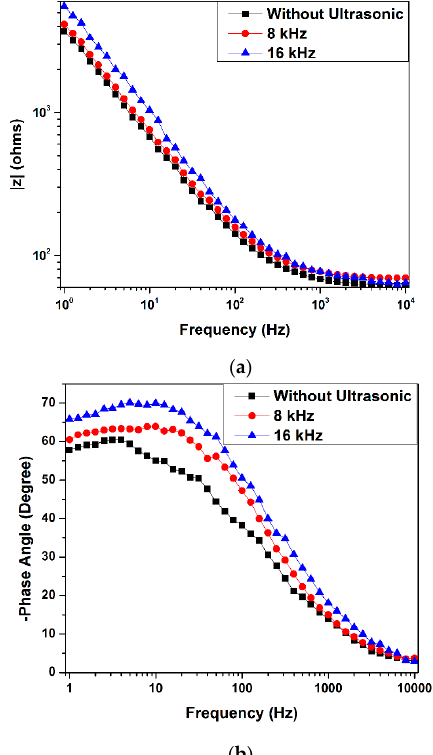
Figure 6. Bode Plots: ( a ) log |z| Vs log f and; ( b ) phase angle Vs log f for ultrasonic treated on TiN coatings at 8 kHz and 16 kHz for various holding times. Table 2. Corrosion parameters calculated from Tafel and electrochemical impedance spectroscopy (EIS) for ultrasonic treatment on TiN coating at 8kHz and 16 kHz for different holding times.